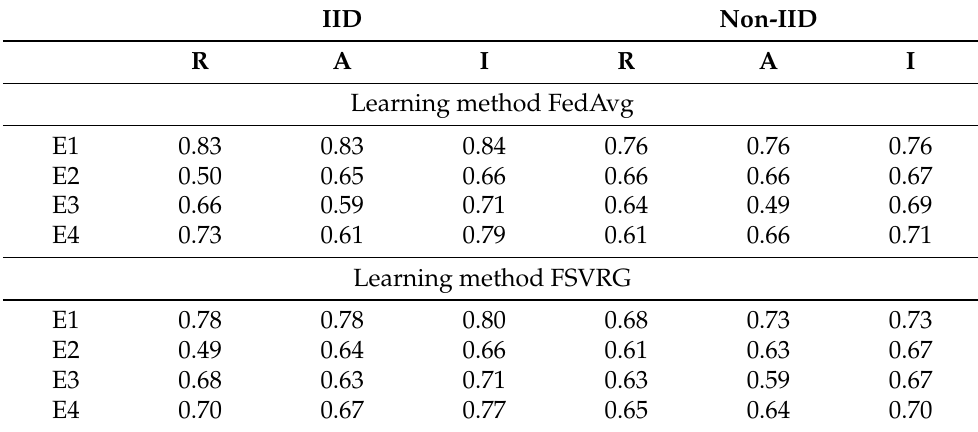
Table 6. Classification accuracies for dataset